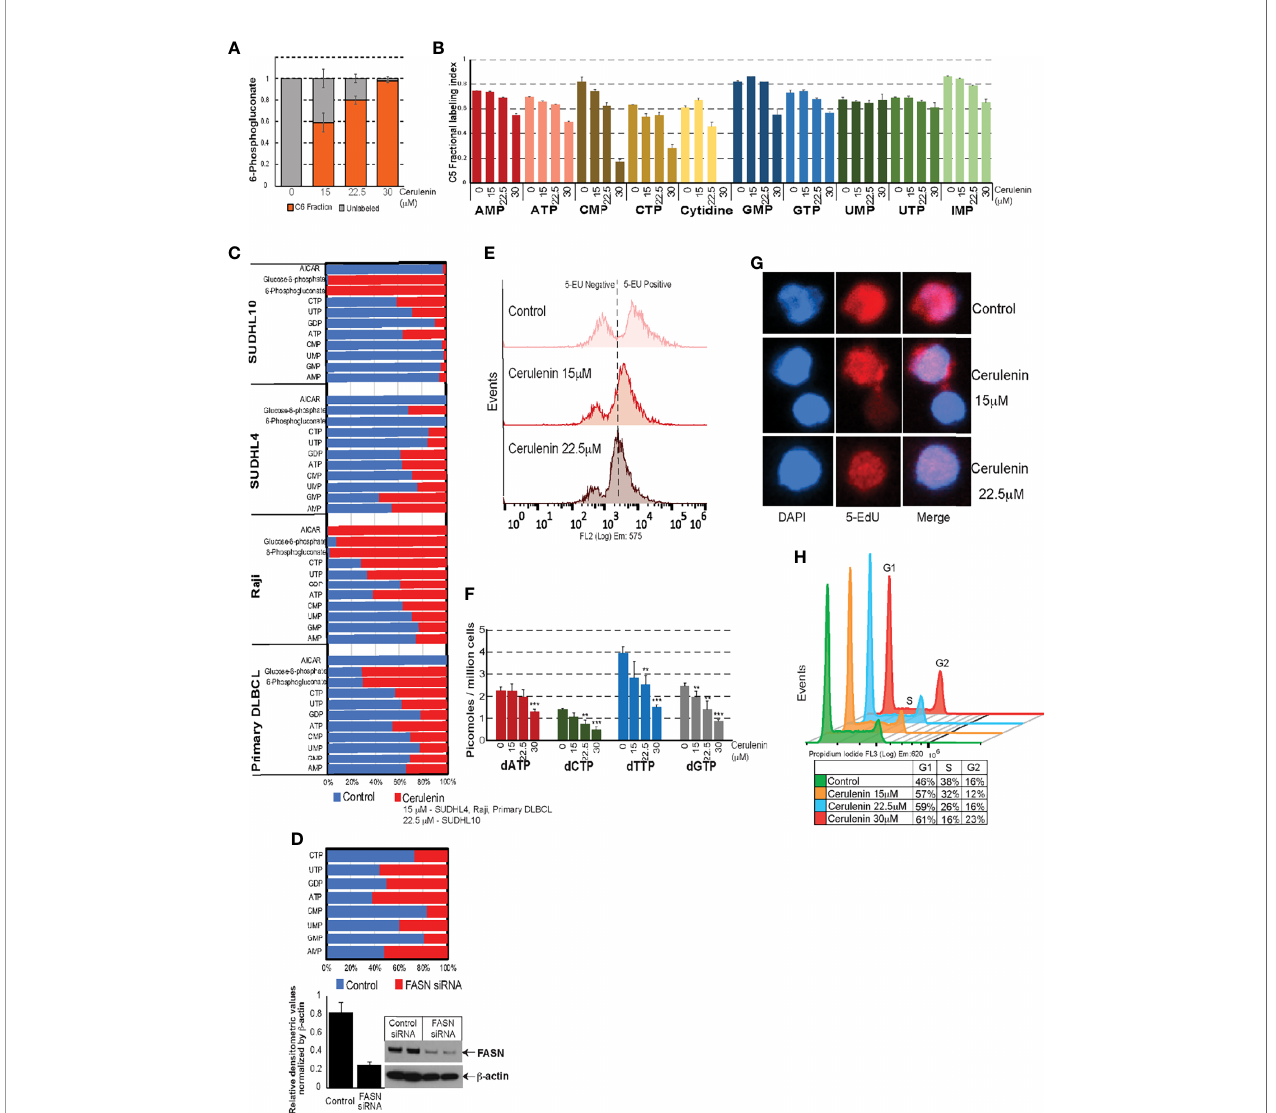
FIGURE 4 | Effects of FASN inhibition on nucleotide metabolism. (A, B) Bar graphs representing C 13 fractional incorporation (in y-axis) in C5 residues of 6PG or nucleotide pools listed on the x-axis, with cerulenin-treated SUDHL10 cells. (C, D) Quantitative mass spectrometry analysis of nucleotide pools represented as fold change (by percentage) with the levels of nucleotides occurring with cerulenin treatment in bNHL cells or with FASN siRNA in SUDHL10 cells. Western blot represents the extent of siRNA-mediated FASN knockdown observed in SUDHL10 cells. Bar graph represents the ratio of FASN protein expression normalized by total b -actin for equal loading. Absolute concentrations corresponding to these fold changes are included in Supplementary Table S1 . (E) Flow cytometry of ClickIT 5-EU pulse-labeled SUDHL10 cells show decreased fl uorescence intensity indicative of RNA global transcriptional activity occurring with cerulenin treatment in SUDHL10 compared to control. (F, G) Bar graph representing changes in the concentration of dNTPs following cerulenin treatment in SUDHL10 cells. Confocal imaging of ClickIT 5-EdU pulse-labeled SUDHL10 cells show decreased 5-EdU (red) incorporation in DNA against DAPI (blue) or merged occurring with cerulenin treatment in SUDHL10 compared to control. All experiments were performed in triplicates; the error bars in all bar graphs represent the standard deviations of mean, and the signi fi cant difference between control and treatment is indicated by an asterisk (** p < 0.05 and *** p < 0.005) statistically determined by Student ’ s t -test. (H) Histogram representing changes in cell cycle occurring with cerulenin treatment based on the fl ow cytometry of propidium-stained SUDHL10 cells at 48 h (H) Overlaid histogram representing cell cycle changes comparing cerulenin with control at 48 h in SUDHL10 cells, detected by propidium iodide staining and fl ow cytometry